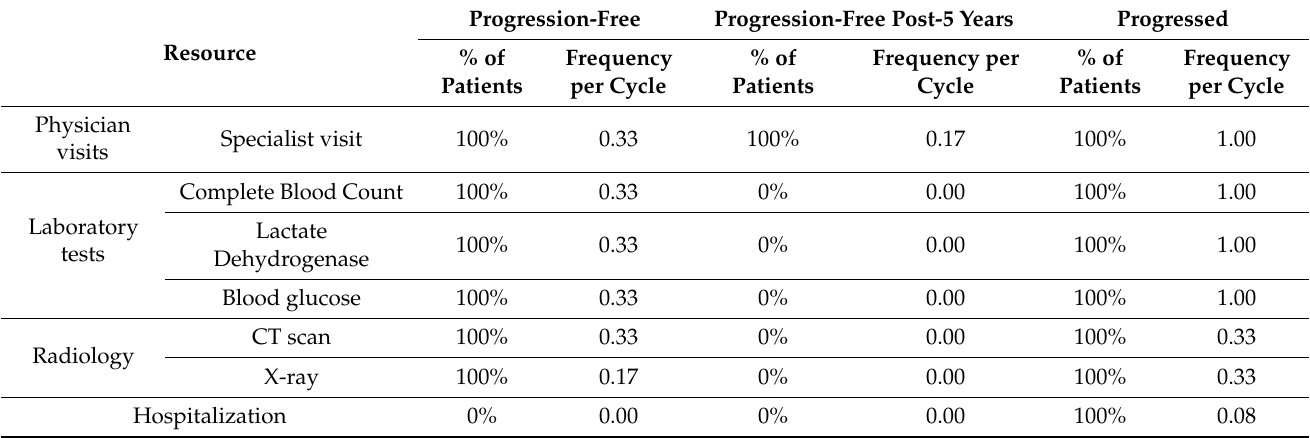
Table A1. Summary of health state resource use frequency, based on Canadian Clinical Expert feedback.